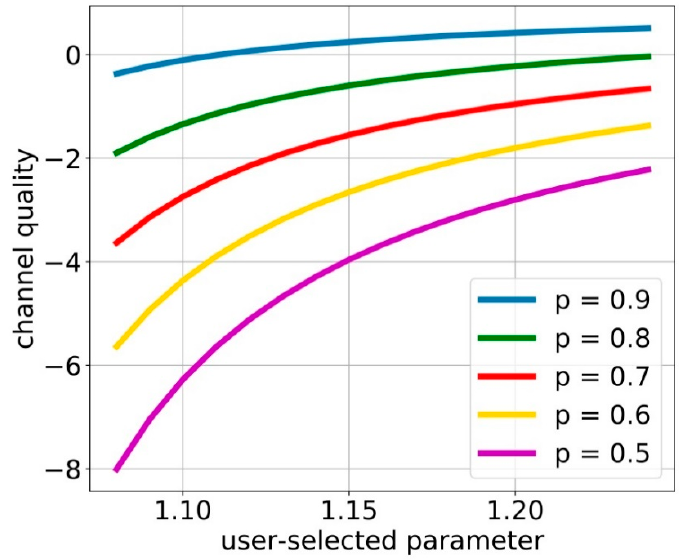
Figure 2. Channel quality metric behaviors.